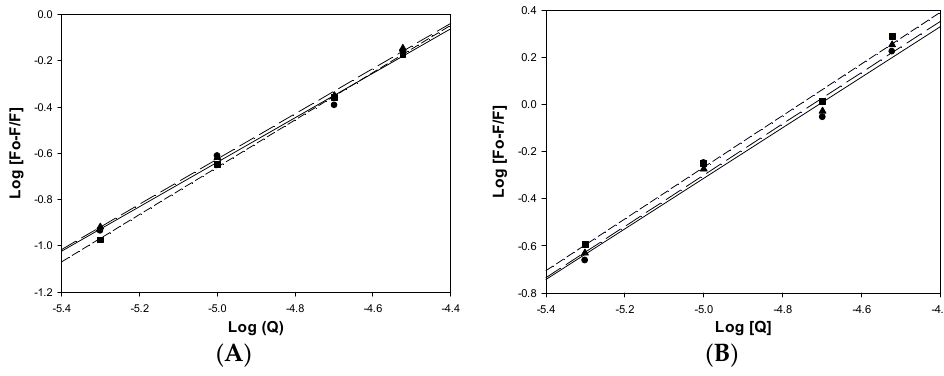
Figure 10. Plots of log (F o − F)/F vs. log [Q] for the naringin-BSA system ( A ) and VONarg-BSA system